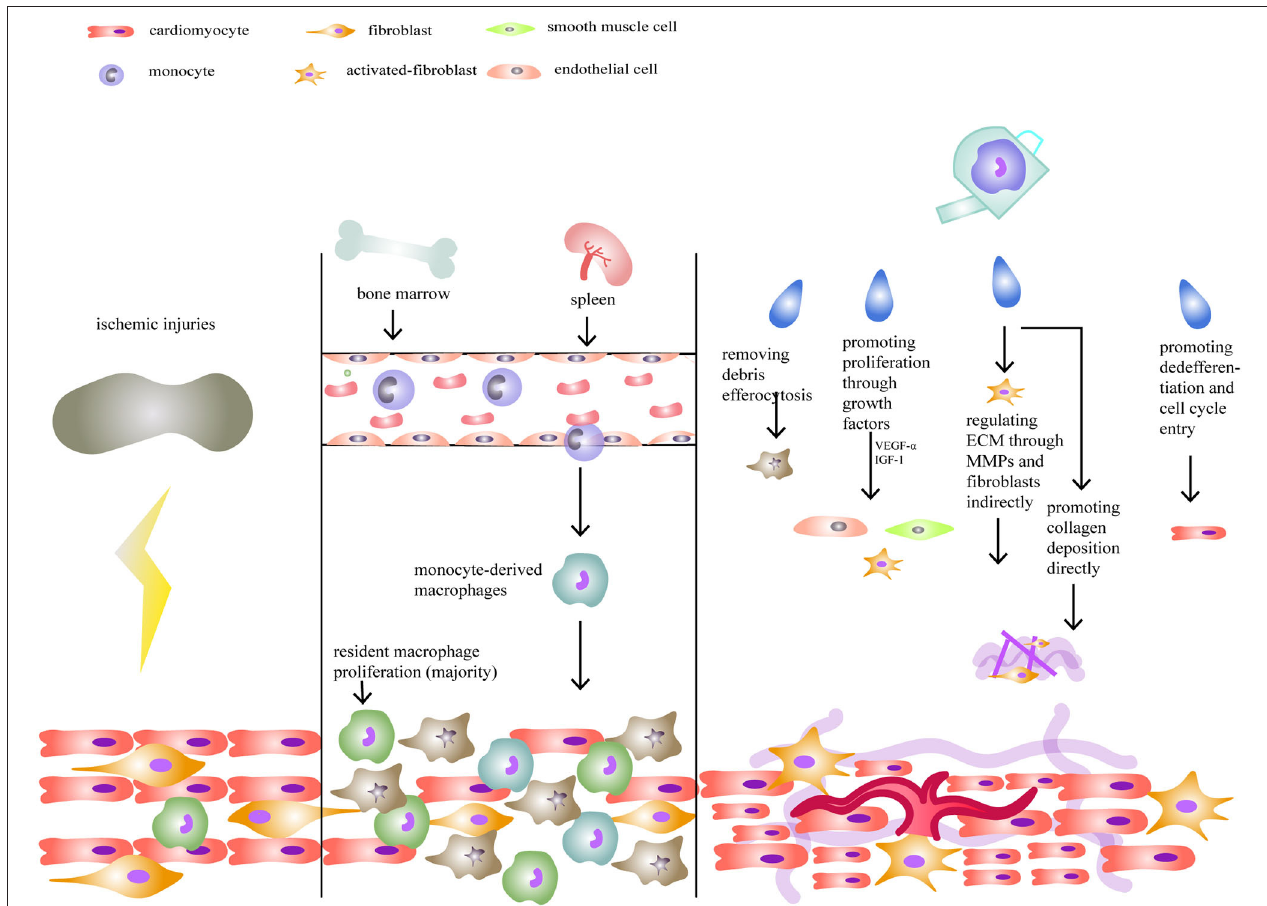
FIGURE 1 | Macrophages and neonatal heart regeneration. After injuries, resident macrophages play a more important role in heart regeneration compared to monocyte-derived macrophages. Their functions include removing debris, promoting cellular proliferation, regulating extracellular matrix (ECM), and stimulating cardiomyocytes to enter the cell